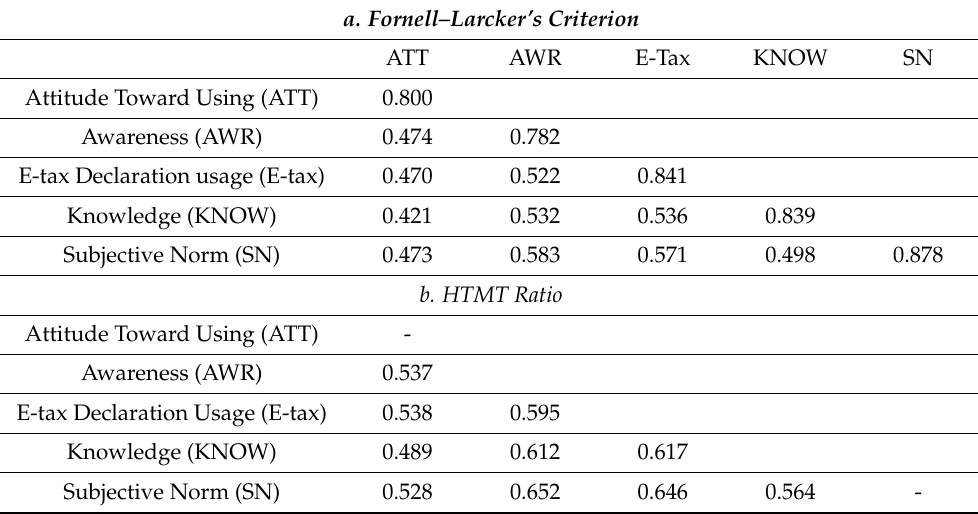
Table 6. Discriminant Validity (Fornell–Larcker’s criterion and HTMT).